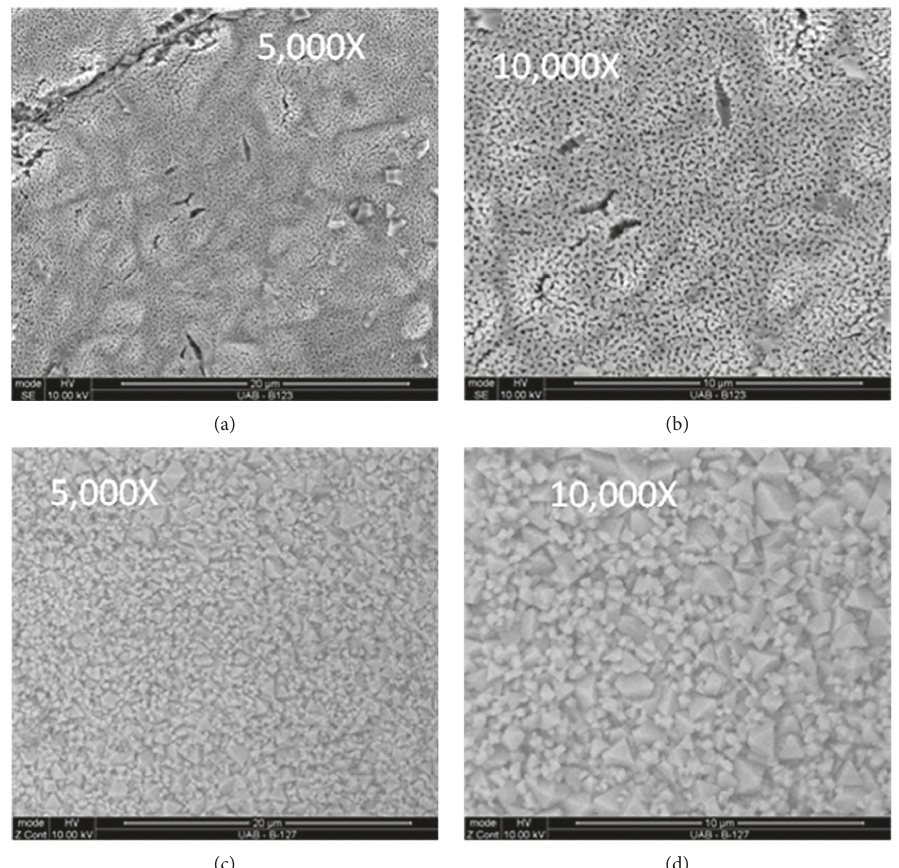
Figure 14: Thermal soak samples. (a) Sample YSZ-B123 at 5,000X. (b) Sample YSZ-B123 at 10,000X. (c) Sample Al Sample Al 2 O 3 -B127 at 10,000X.